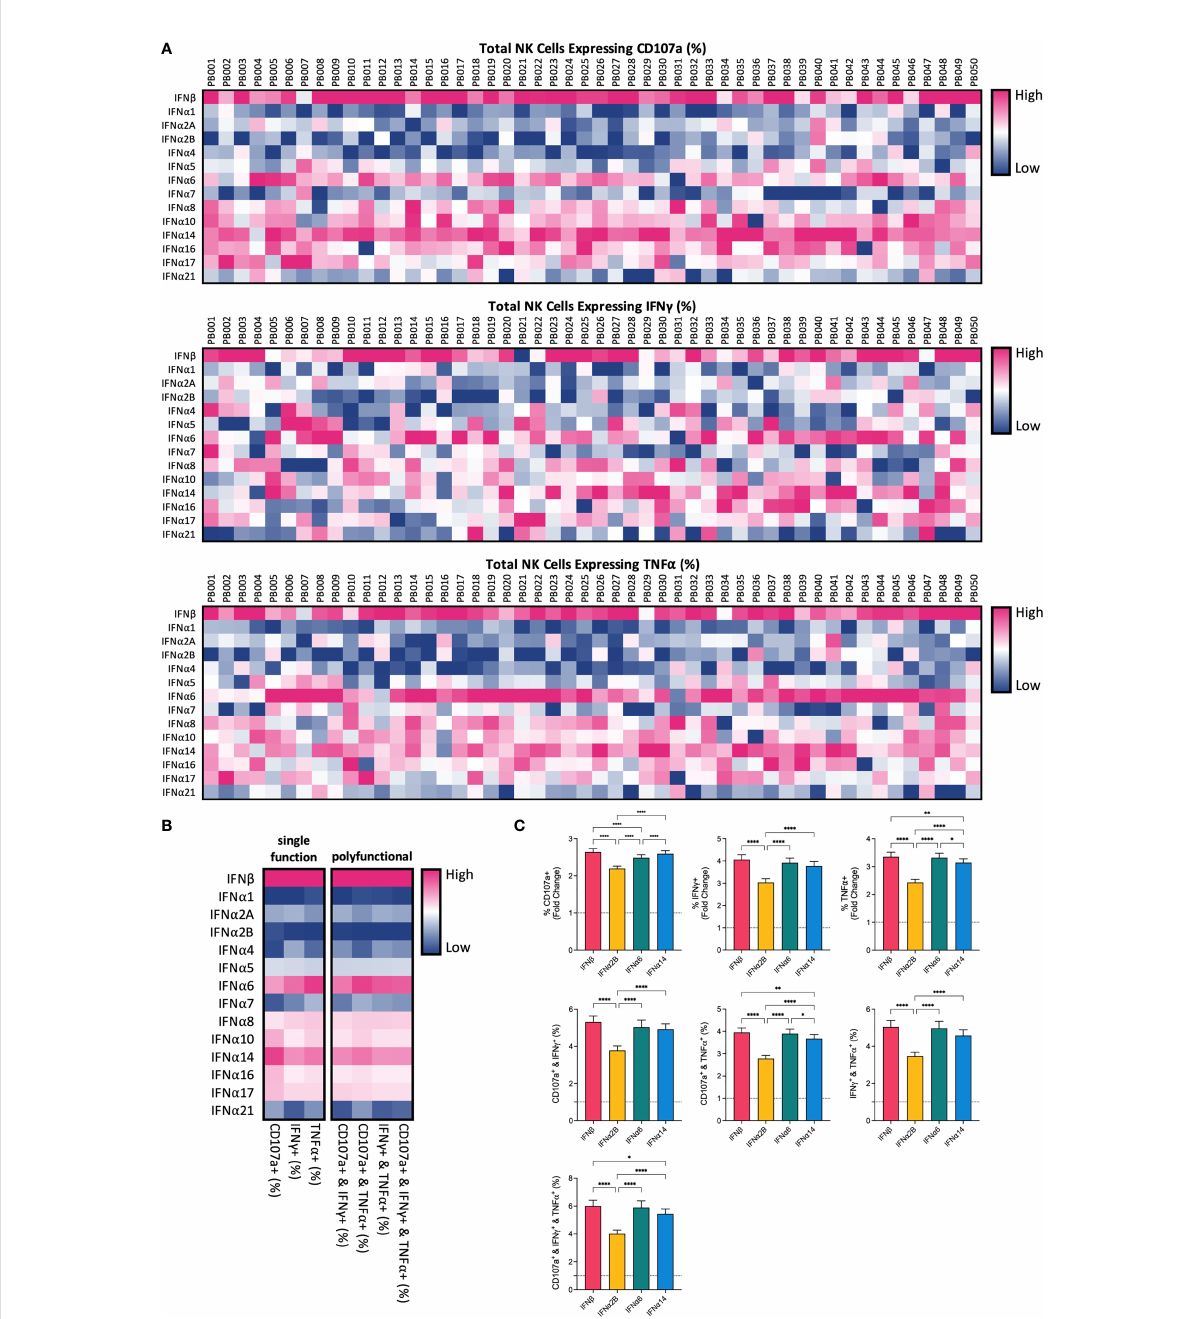
FIGURE 1 IFN-I subtypes differentially activate NK cell effector functions PBMCs from 50 healthy donors (PB001-PB050) were either left unstimulated (baseline; data not shown) or were stimulated with 100 IU mL -1 of each IFN a ; subtype or IFN b overnight. Following overnight activation, cells were washed and then co-incubated with K562 cells for 5 hours at a 2:1 E:T ratio and NK cell effector functions were assessed. (A) Heatmaps summarizing the percentage of CD56 + CD3 neg NK cells expressing CD107a (range: 17.40-81.10%) or producing IFNy (range: 4.19-50.20%) or TNF a (range: 2.24-74.4%) for each donor in response to individual IFN-I subtypes. (B) The mean percentage of NK cells expressing CD107a, IFNy or TNF a , or a combination of two or more of these functional markers, was calculated for each IFN-I subtype across all donors. (C) Summary data show mean ± SEM fold change difference in the percentage of NK cells expressing CD107a, IFNy or TNF a , or a combination of two or more of these functional markers, following stimulation with selected IFN-I subtypes compared to baseline (dotted line). Data were compared using paired Student ’ s t tests. * p < 0.05, ** p < 0.01, **** p <